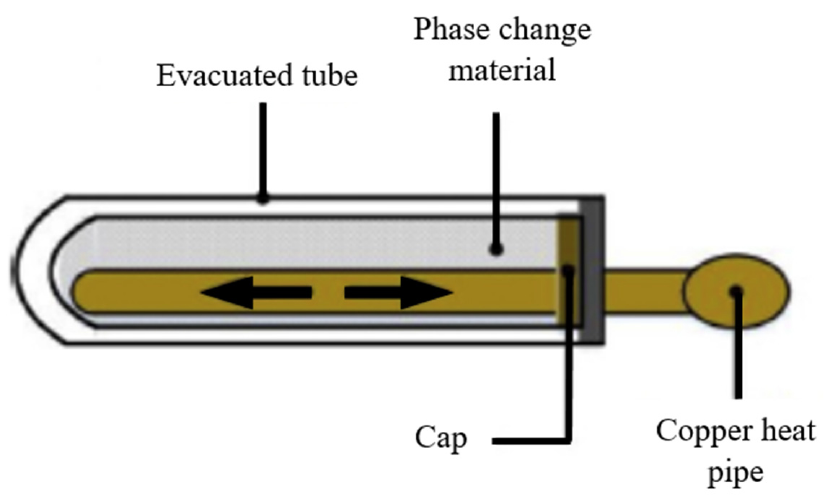
Figure 12. The design of an evacuated tube heat-pipe collector is fully embedded in the PCM layer. Adapted with permission from ref. [121] 2016 Papadimitratos et al.